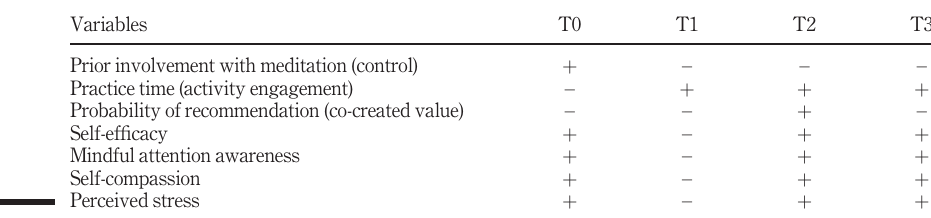
Table 1. Measurements